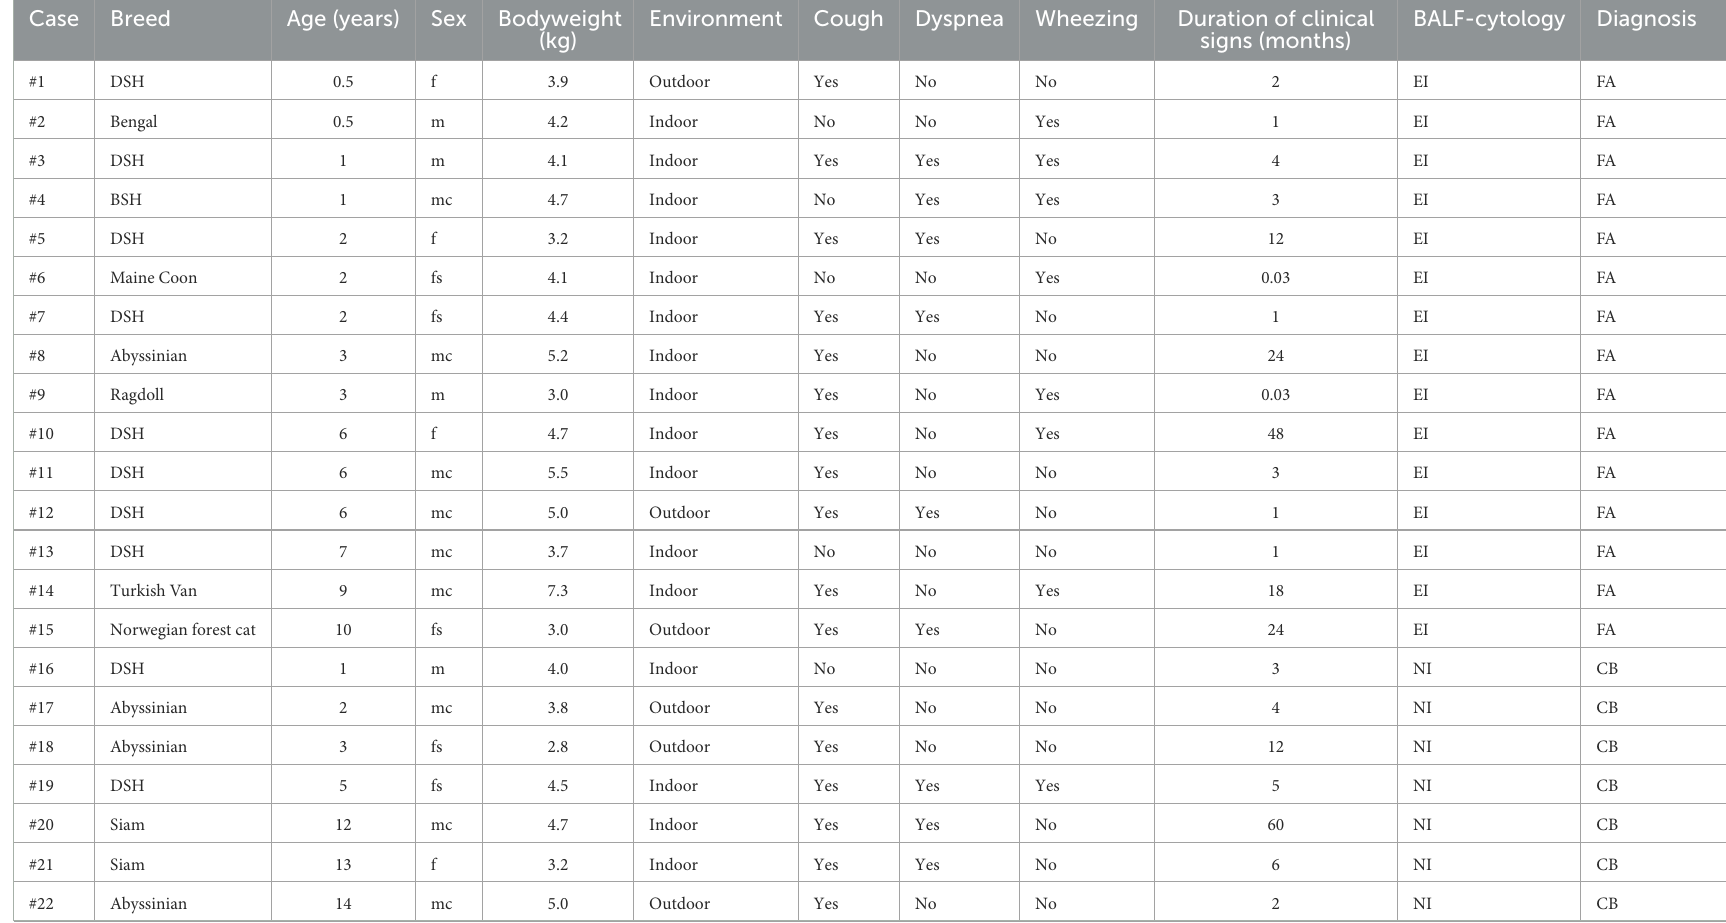
TABLE 2 Demographic data, clinical signs, BALF-cytology and final diagnosis of cats with chronic bronchial disease.